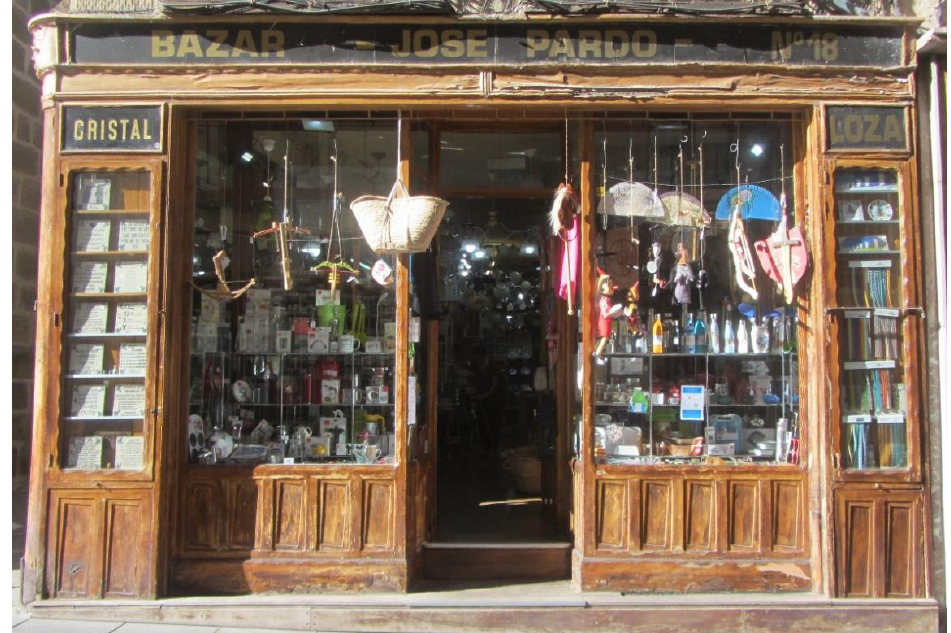
Figure 5. José Pardo Bazar in the Old Town of Á vila (2021). Phase 3. Source: Author. Figure 5. Jos é Pardo Bazar in the Old Town of Á vila (2021). Phase 3. Source: